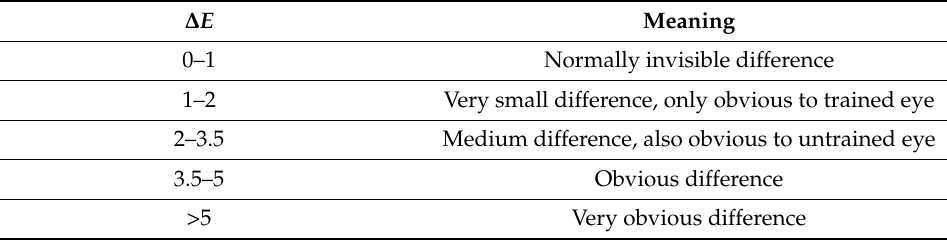
Table 3. ∆ E values and their corresponding color differences